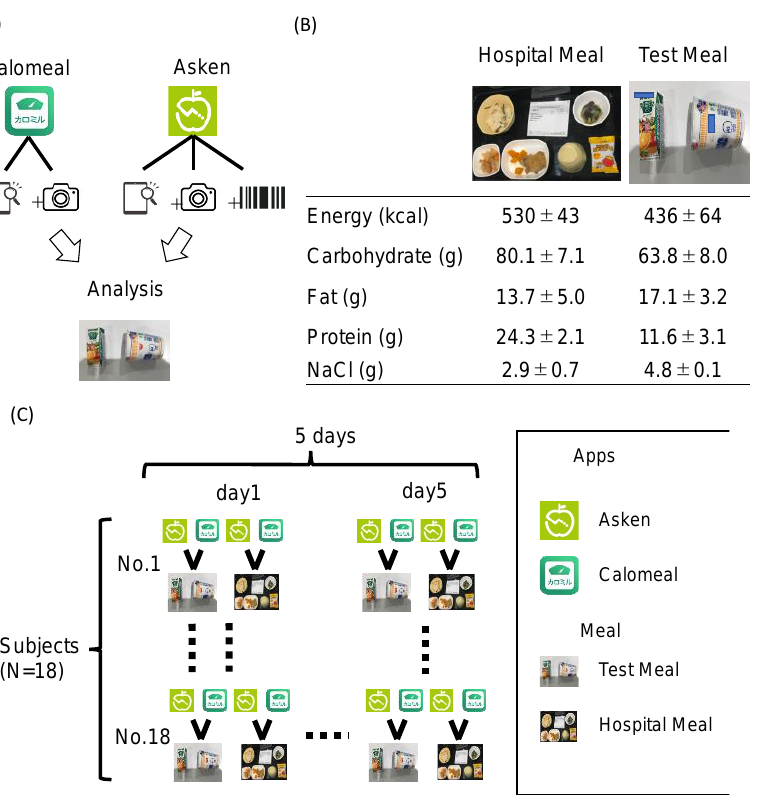
Figure 1. The characteristics of the Calomeal and Asken apps and the procedure of this study. ( A ) The Calomeal and Asken apps have image-analysis functions based on photos and food-search functions based on names. In addition, the Asken app has a search function based on product barcodes. Subjects were allowed to use all photo analyses, searches by product name, and barcode searches (Asken only) for analysis. In this study, all functions were used to analyze meals rather than specific functions. For example, if the photo analysis showed the wrong food, then it could be corrected by manually entering the name or by scanning the barcode. ( B ) Comparison between the hospital meal and test meal. Data represent the mean ± S.D. (n = 5). ( C ) Procedure of this study. Subjects were